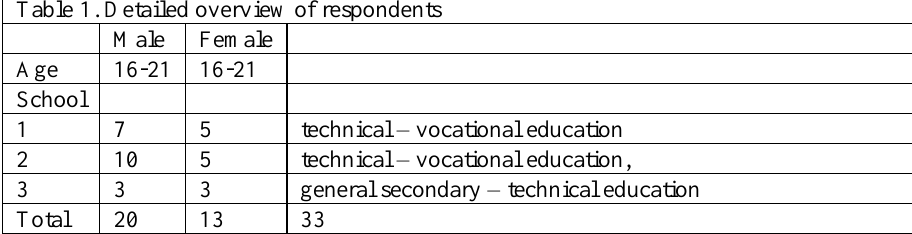
Table 1. Detailed overview of